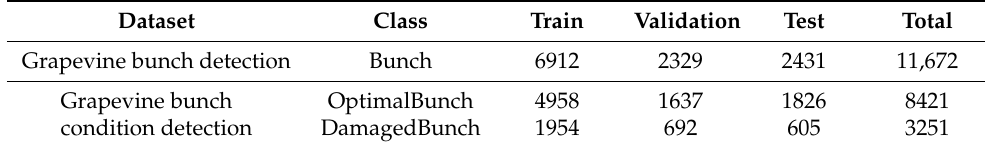
Table 3. Number of annotated objects per class in each set.